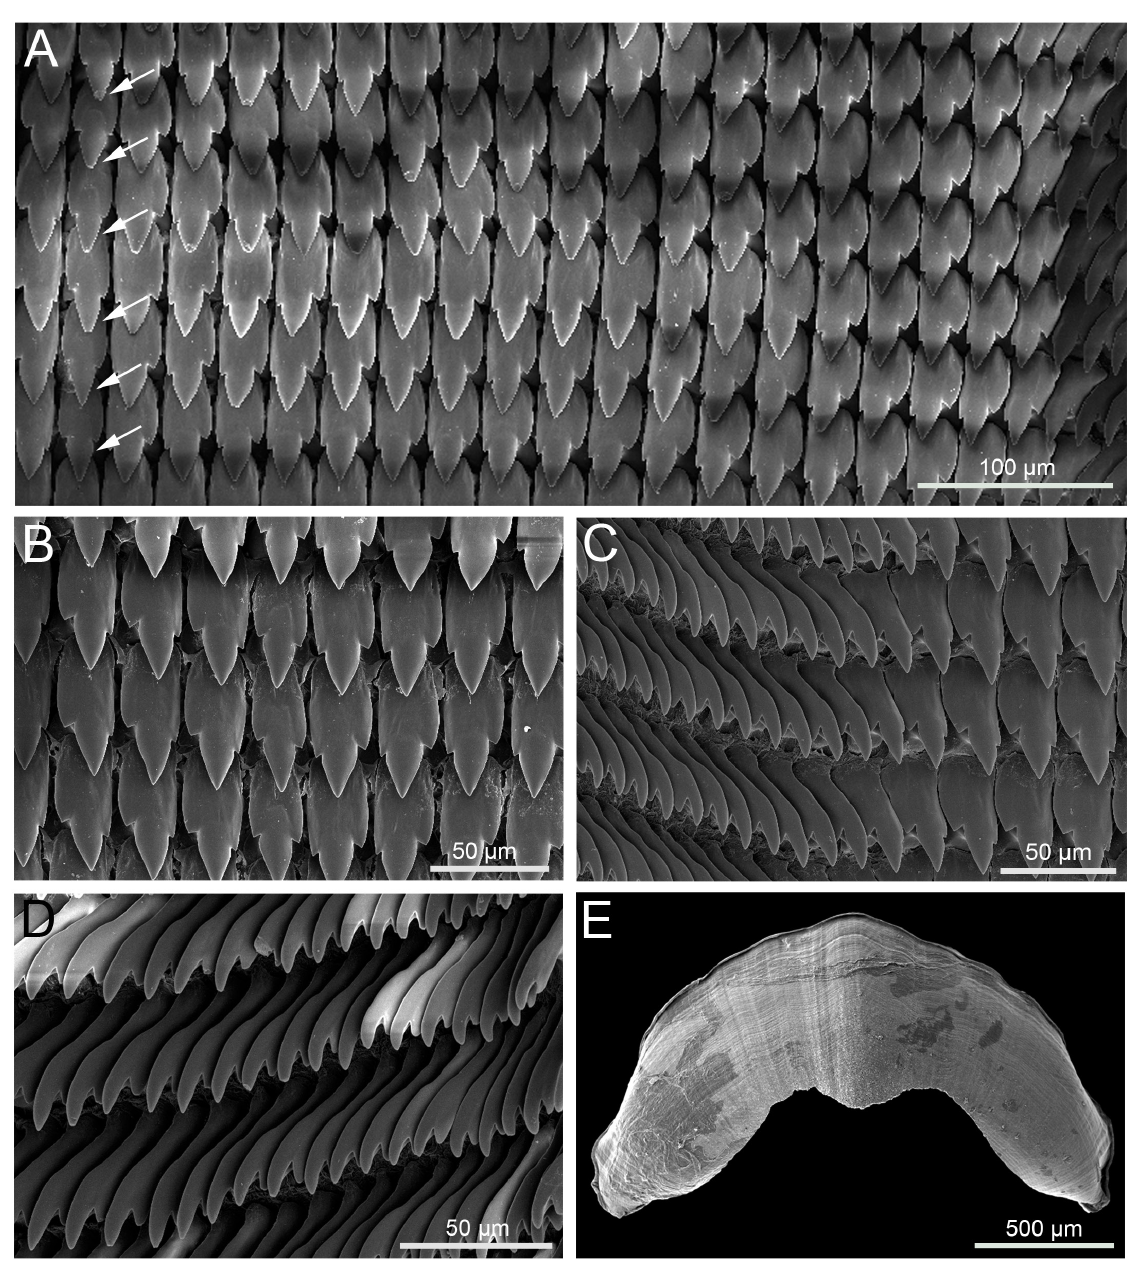
Fig. 12. Radula and jaw of a paratype (BNHS GAS 127) of Varadia amboliensis Bhosale, Thackeray, Muley & Raheem gen. et sp. nov. A . Central (indicated by arrows), inner lateral and outer lateral teeth. B . Central and inner lateral teeth. C–D . Marginal teeth. E . Jaw. Note median